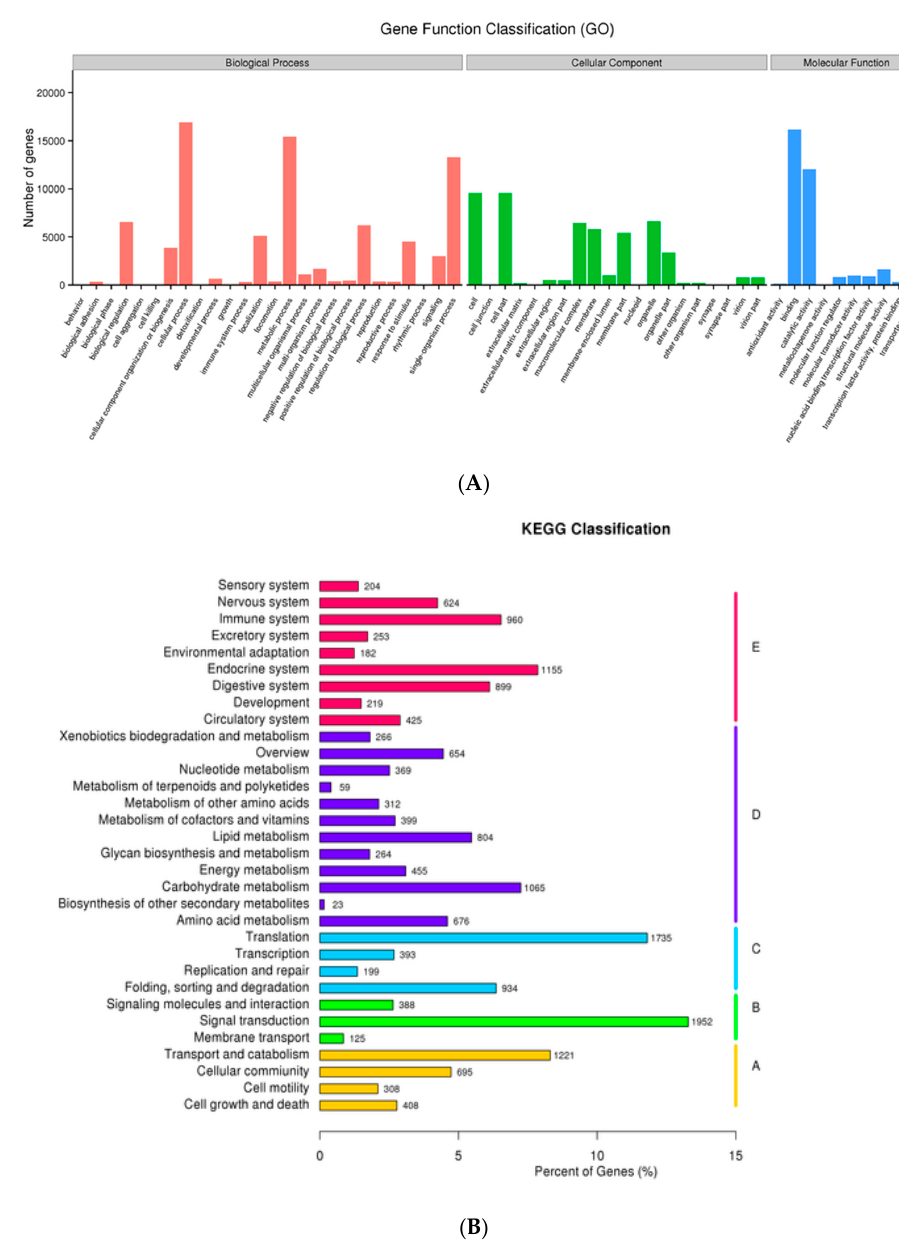
Figure 3. ( A ) The unigene GO annotation including the biological process, cellular component, and molecular function. ( B ) The KEGG classification of unigenes, where A is Cellular process, B is Environmental information processing, C is Genetic Information Processing, D is Metabolism, and E is Organismal Systems.